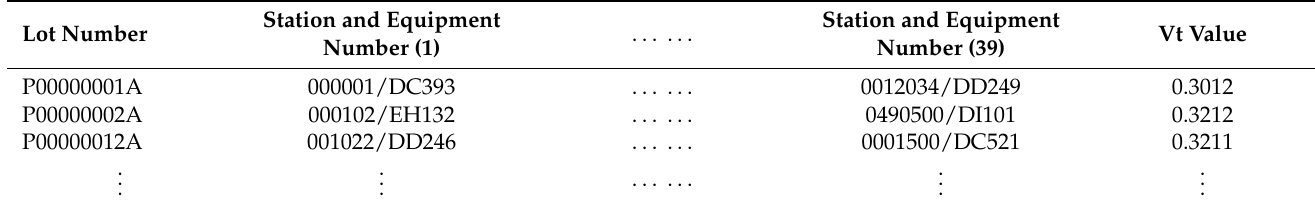
Table 1. The results of the collected partial data.